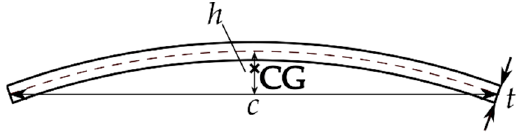
Figure 5. Circular-arc-cambered plate (8% relative camber).